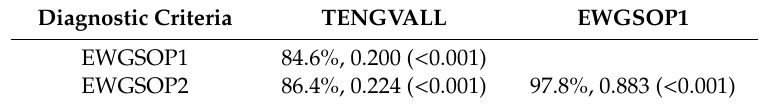
Table 2. The agreement analysis among the diagnostic criteria for low ASMI in